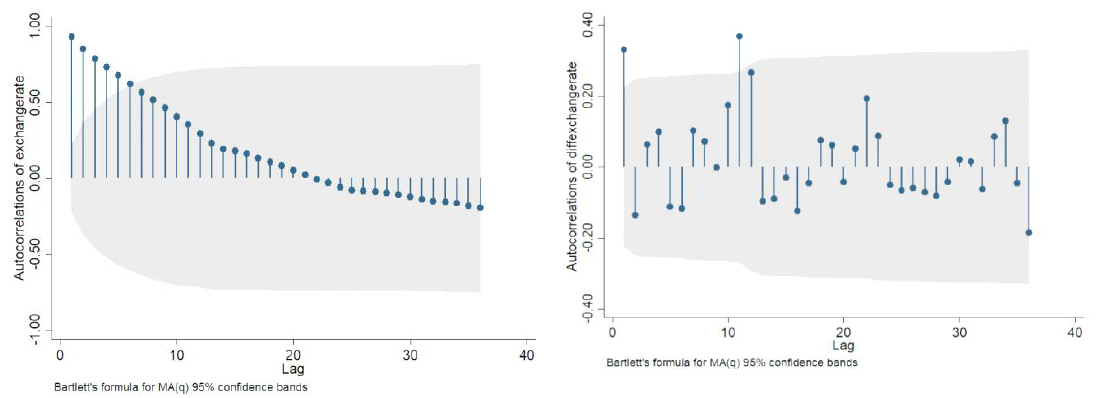
Figure 3. Autocorrelation diagrams, USD/UAH exchange rate, 2014 – May 2020 (left side – in absolute values, right side – in first differences)